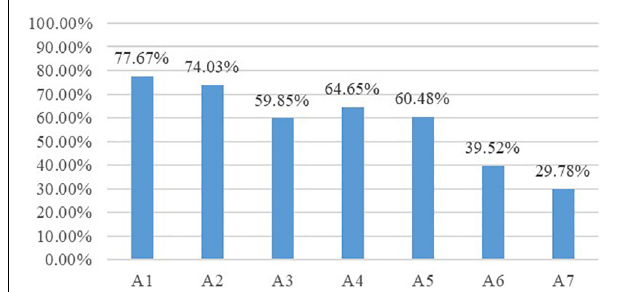
FIGURE 1 | Attribute prevalence of the examinee group.